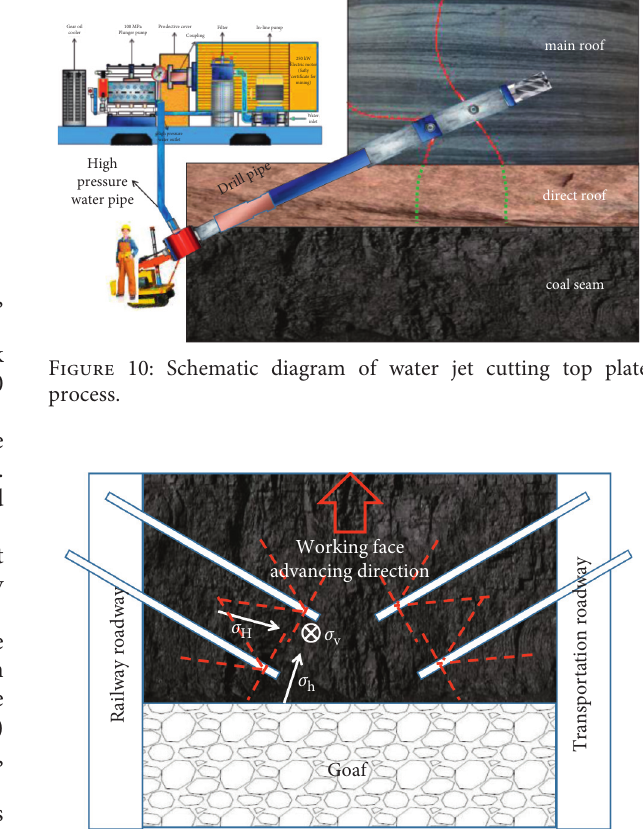
Figure 11: Schematic diagram of drilling layout